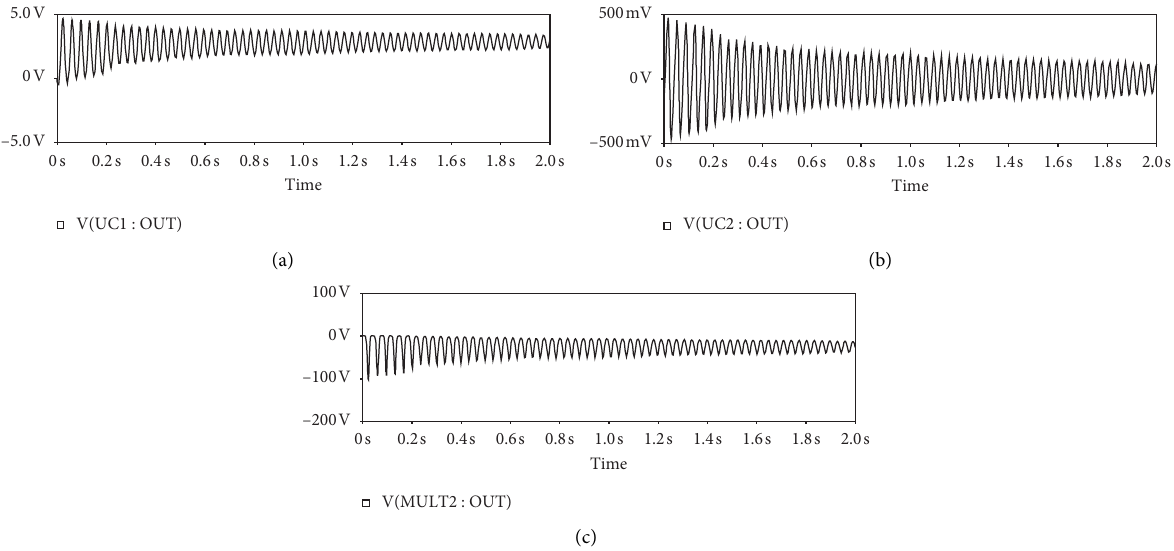
Figure 9: Output voltages of (a) amplifier with capacitor C � 100nF , C C 1